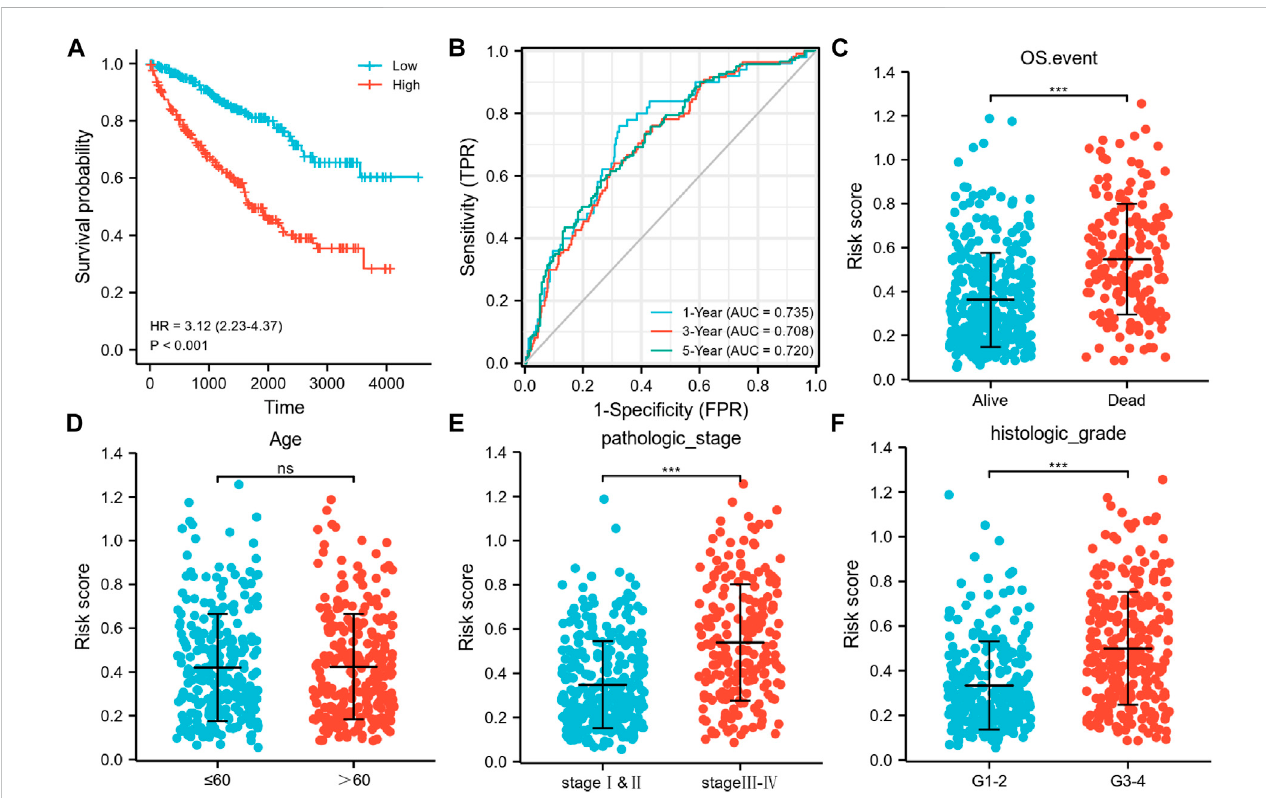
FIGURE 5 Associations of the six immunity-related genes signatures with OS, AUC curves, and clinicopathological features in KIRC. (A) Kaplan-Meier curve exhibitedsubstantialvariationinOSacrossthehigh-andlow-riskgroupsintheTCGA-KIRCcohort. (B) Time-dependentROCcurvesforpredicting1-,3-,and 5-year survival rates. Relationship between signature risk scores and clinicopathological features in (C) OS events (Alive vs. Dead; unpaired Student ’ s t-test, p < 0.001), (D) age ( > 60 vs. ≤ 60; unpaired Student ’ s t-test, p > 0.05), (E) Pathological stage of tumor (stage I – II vs stage III – IV; unpaired Student ’ s t-test, p < 0.001), (F) Histological grade of tumor (G1 – 2 vs G3 – 4; unpaired Student ’ s t-test, p <